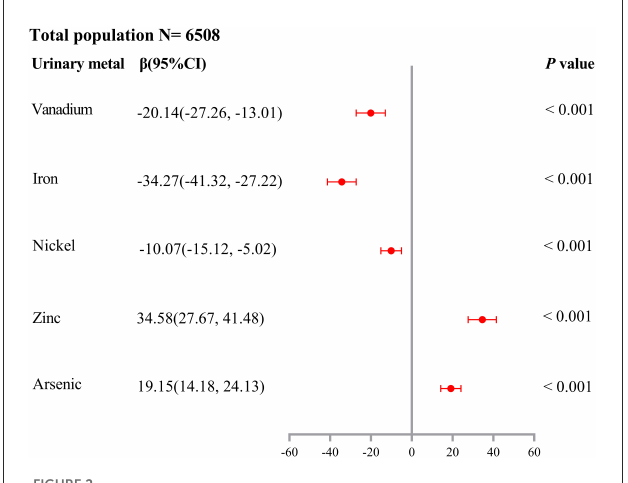
FIGURE2 Association of a 1-SD increase in log-transformed urinary metal concentrations of vanadium, iron, nickel, zinc, and arsenic with SUA levels ( β and 95% confidence interval). Multiple linear regression models were performed and adjusted for age, gender, education level, marital status, active smoking status, passive smoking status, drinking status, hypertension, diabetes, hyperlipidemia, BMI, eGFR, and urine